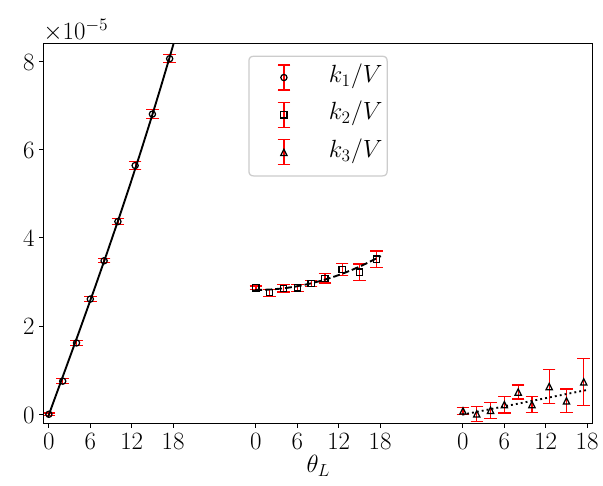
Figure 5 . Best fit of the first 3 cumulants (solid, dashed and dotted line respectively) for N = 6, β = 25 . 750 and θ L [0 , 17 . 5], obtained considering up to O ( θ 4 ) terms in the Taylor expansion of L ∈ the vacuum energy, i.e., neglecting b 4 in eqs. (2.7). The best fit yields χ 2 / dof = 14 . 4 /